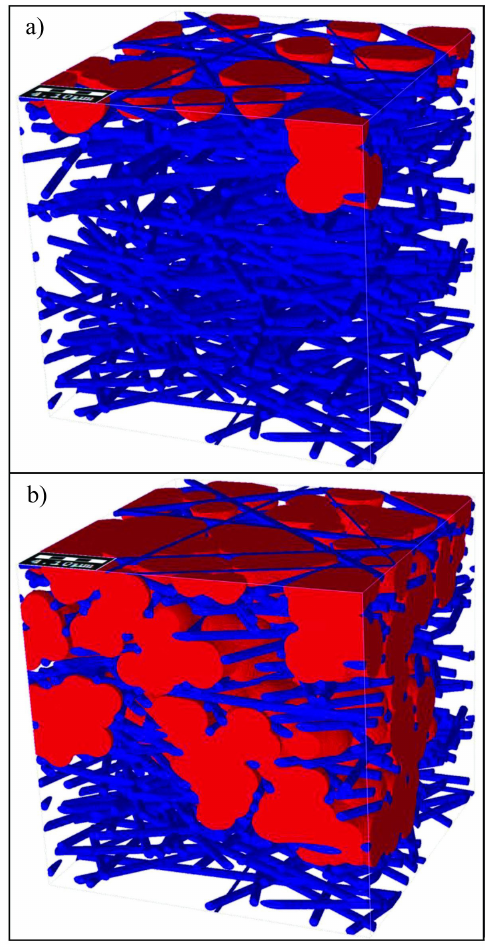
Figure 30. visualization of two stages of water intrusion into unimodal fibrous structure with random in-plane fiber orientation using full morphology method at two different